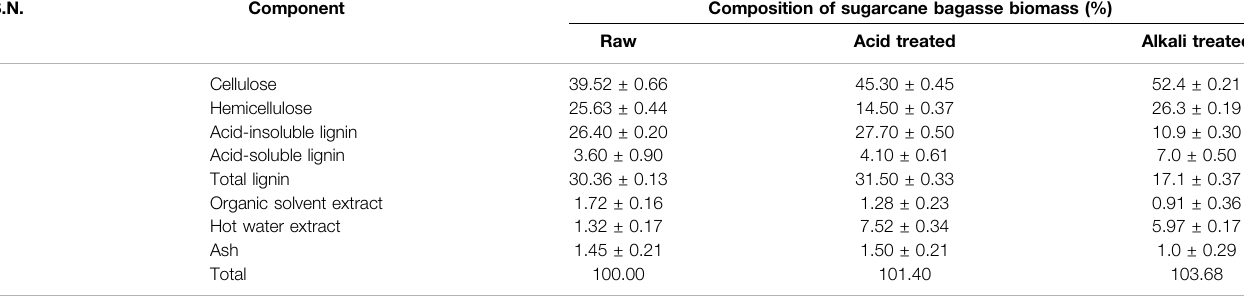
TABLE 1 | Compositional analyses of the raw, acid-, and alkali-pretreated sugarcane bagasse (SB).